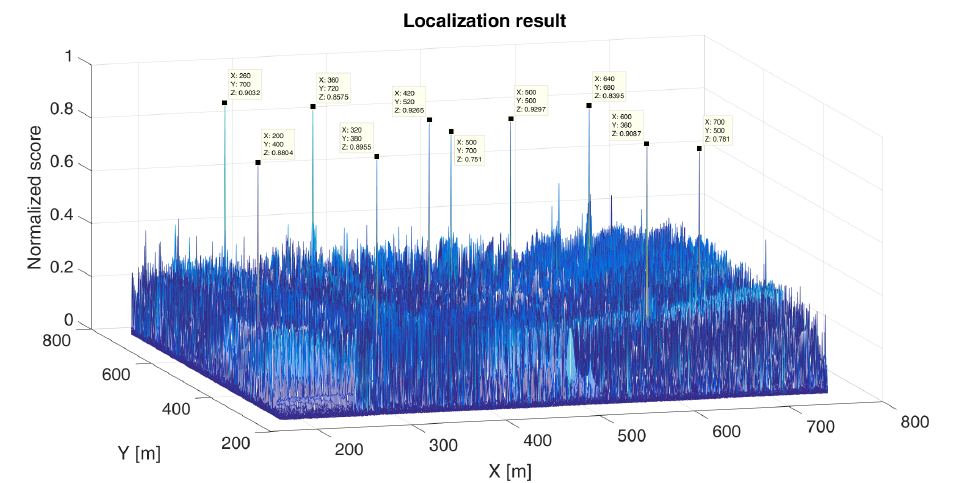
Figure 10. The localization results of 10 sources.